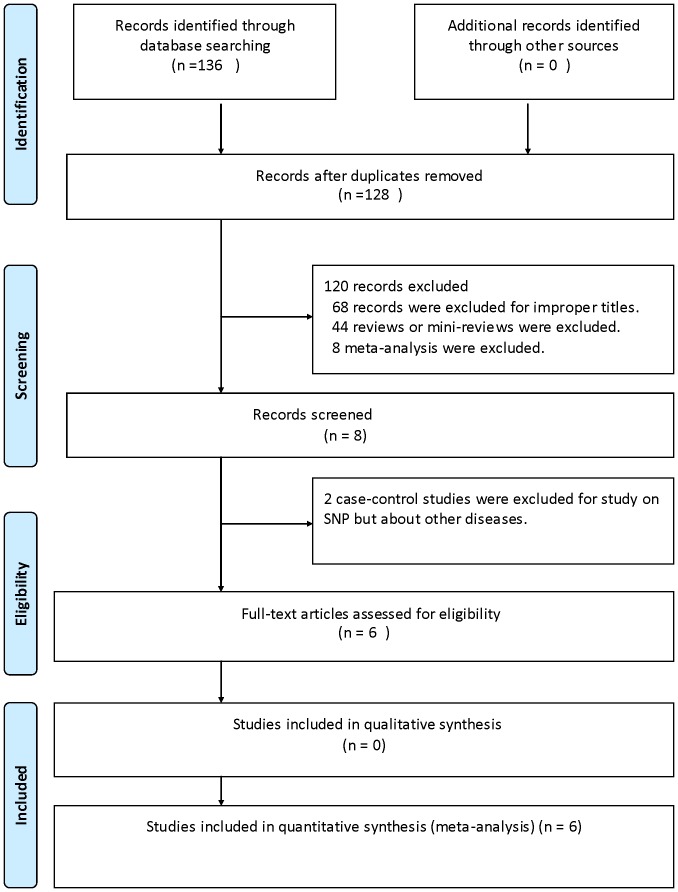
Flow diagram of study identification.